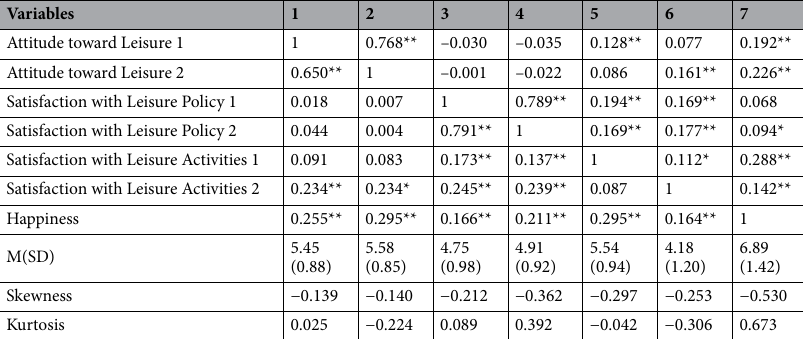
Table 2. Correlations, mean values, standard deviation, skewness, and kurtosis of variables. * p < 0.05, ** p < 0.01. The upper triangular matrix represents the correlation values for the female group, and the lower triangular matrix represents the correlation values for the male